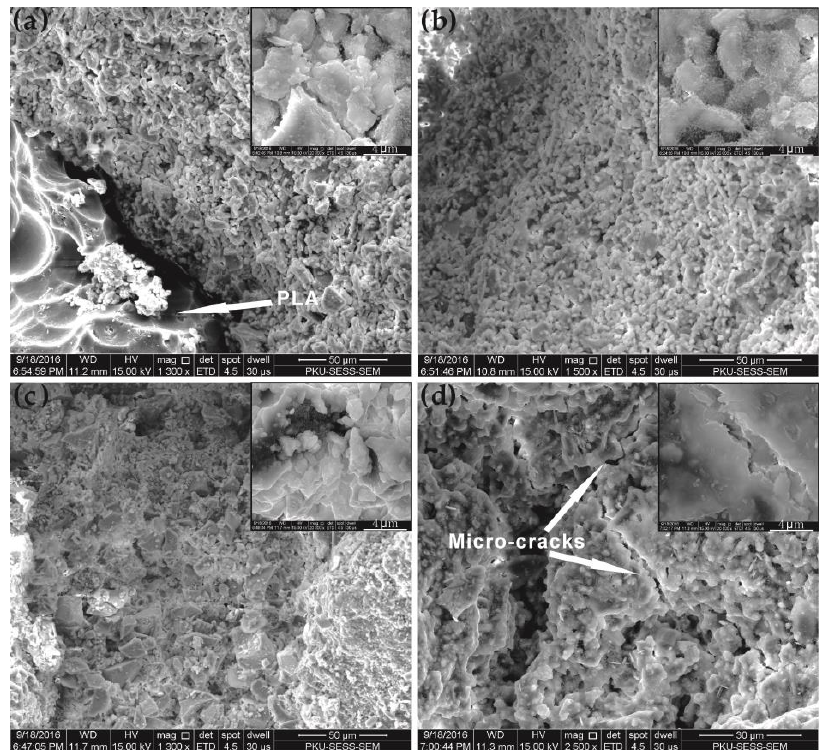
Figure 13. SEM images of greater magnification of the SDTSM with 2% PLA after different periods: ( a ) 85 °C-cured; ( b ) 200 °C-heated; ( c ) immersed in water for 2 h and ( d ) immersed in water for 24 h.